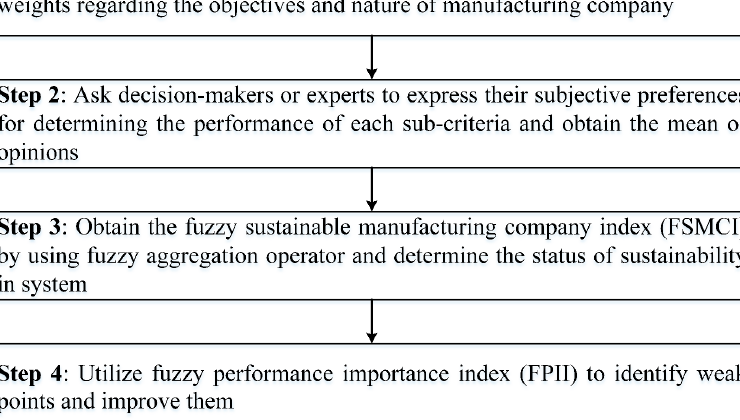
Figure 3. The steps of the proposed methodology.